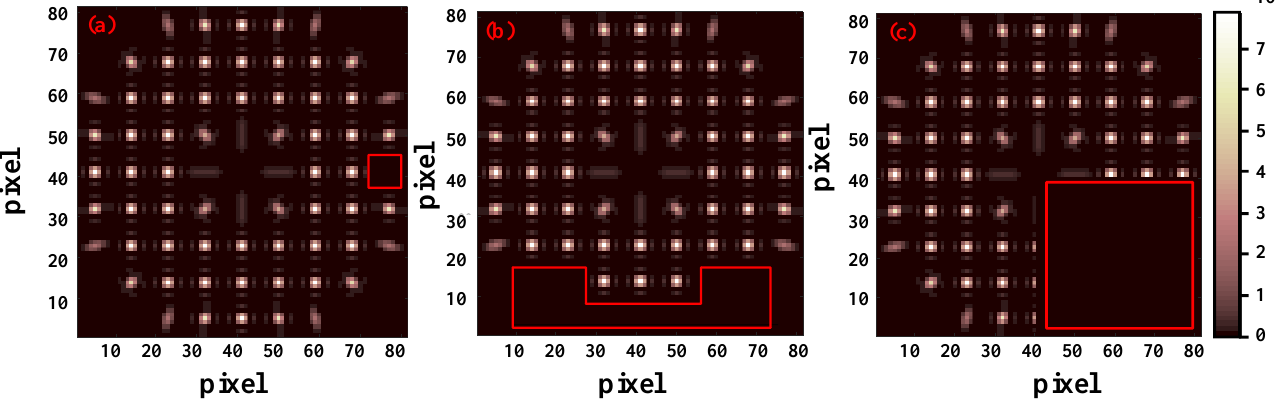
Figure 4. Three cases of under-sampling with sub-apertures lack of light. ( a ) a single sub-aperture numbered 29 lack of light, ( b ) a row of sub-apertures numbered 43, 44, 50, 51, 52, 48, 49 at the bottom lack of light, ( c ) a quadrant sub-aperture numbered 33-35,40-49, 52 lack of light. For r 0 is 10 cm, the distorted original wavefront, reconstructed wavefront, and the corresponding residual wavefront were shown in Figure 5. The RMS of the aberrant wave- front is 1.0758 . The RMS of the residual wavefront with a sampling of all the sub-aper- tures, under-sampling of one sub-aperture, under-sampling of a row of sub-apertures,